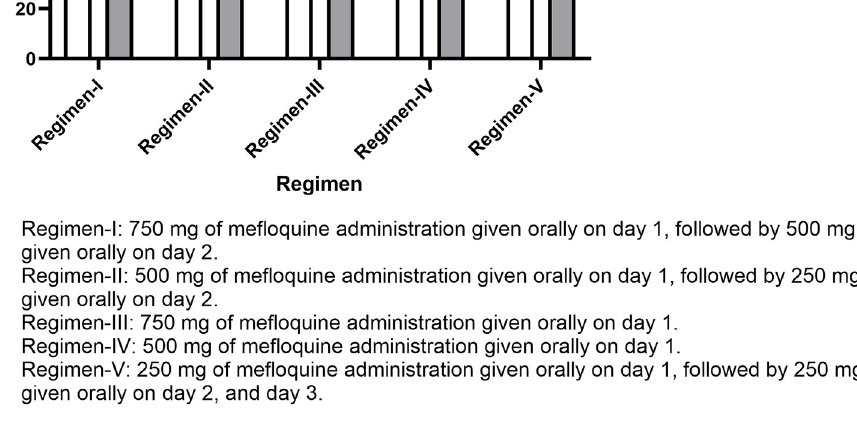
Fig 9. Comparisons of treatment efficacy of five proposed regimens between two IC50 values in patients with sensitive